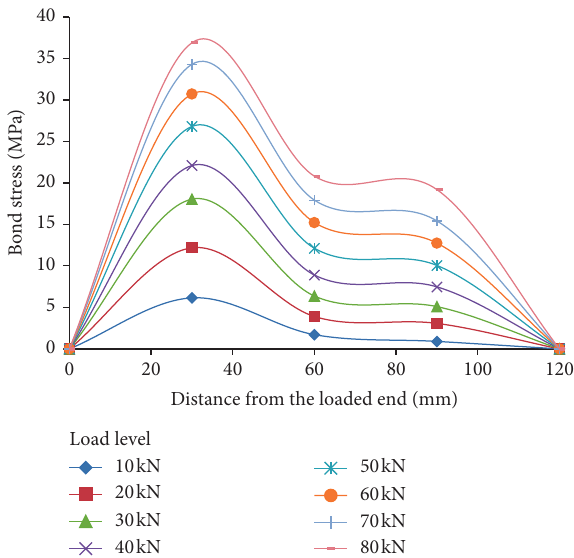
Figure 14: Average bond stress distribution for ribbed bar-rein- forced